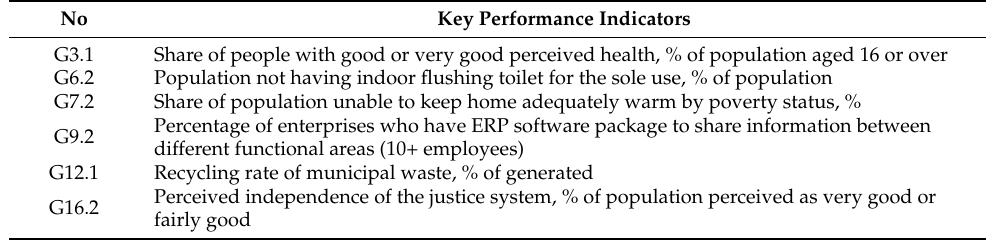
Table 1. Key performance